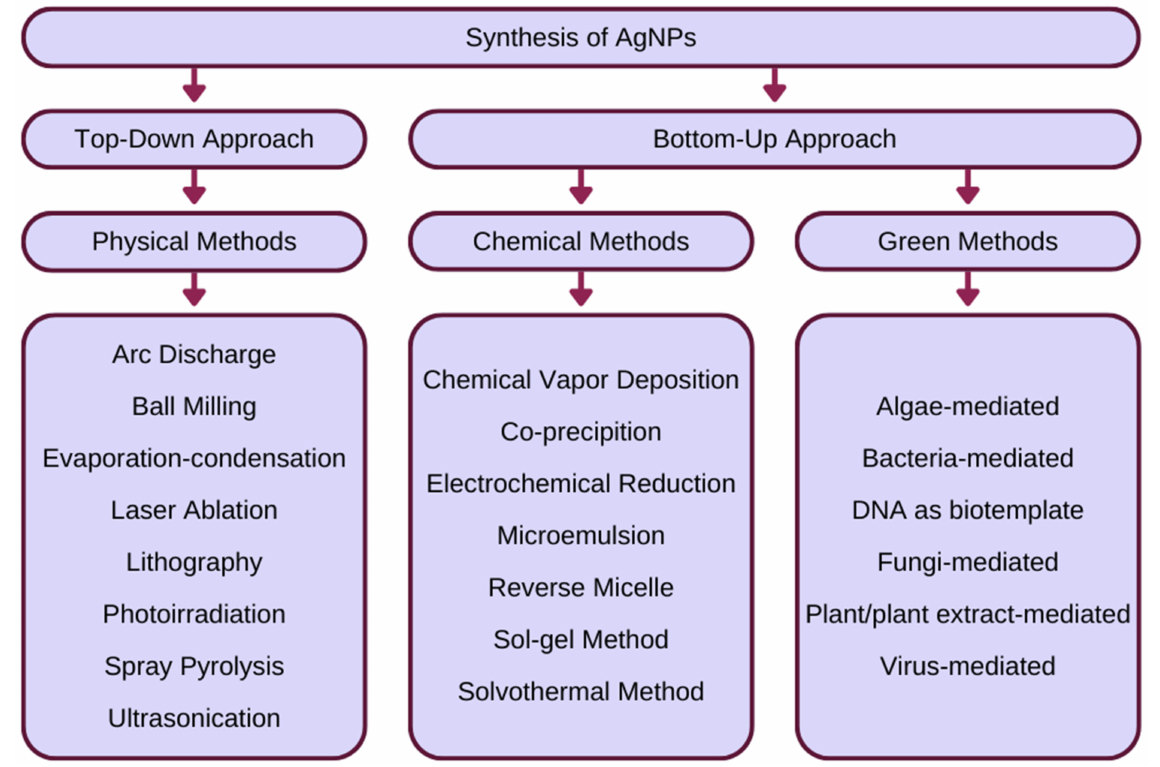
Figure 1. Classification of physical, chemical, and green synthesis techniques of AgNPs, based on